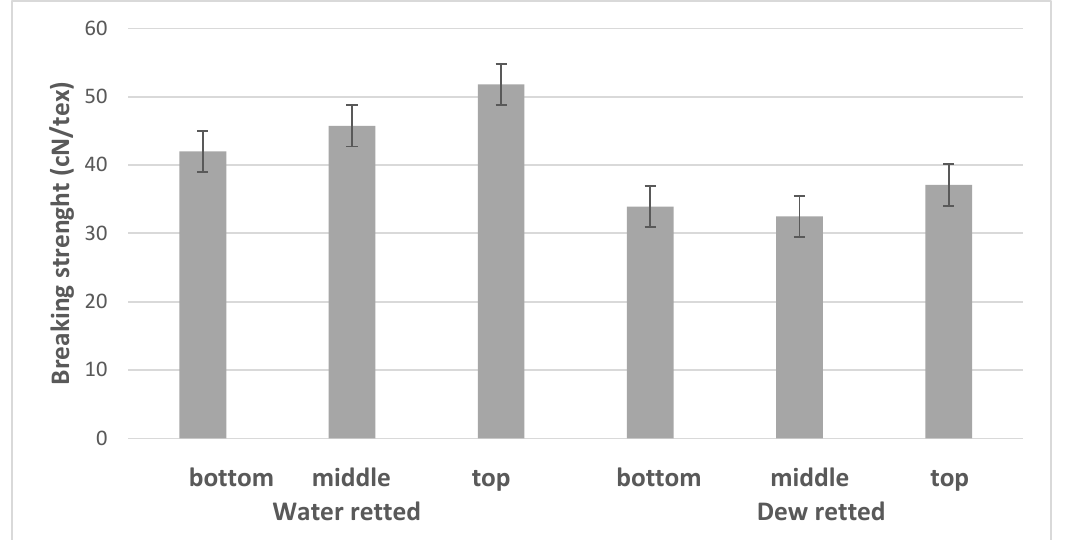
Figure 5. Effect of plant section used for fiber extraction and the retting method on fiber breaking strength (cN/tex) (Error bars represent standard errors).